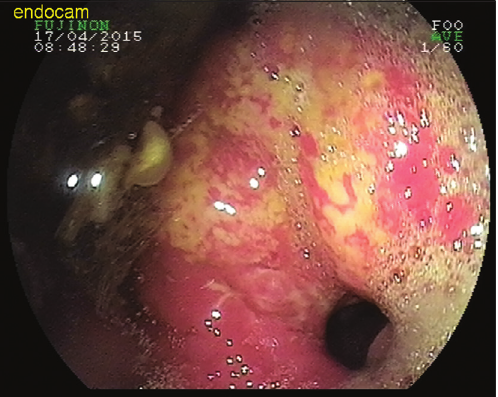
FIGURE 1. Endoscopic unusual appearance remnant gastric adenocarcinoma